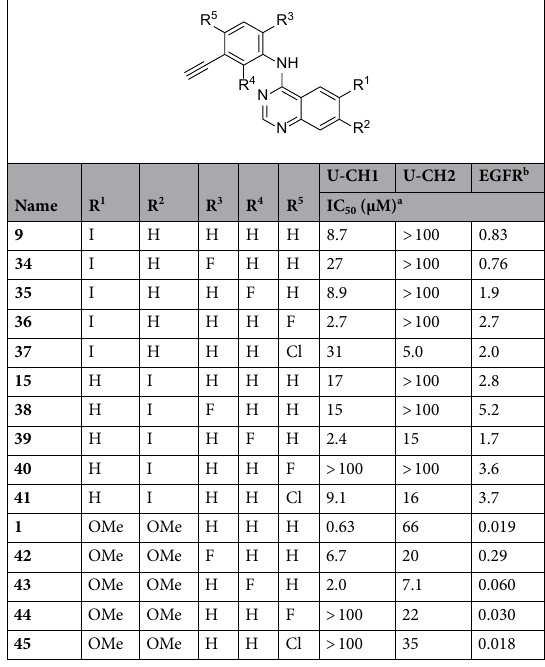
Table 5. Optimisation of 9 , 15 and 1 on EGFR and UCH-1 and UCH-2 chordoma cell lines. a Cell